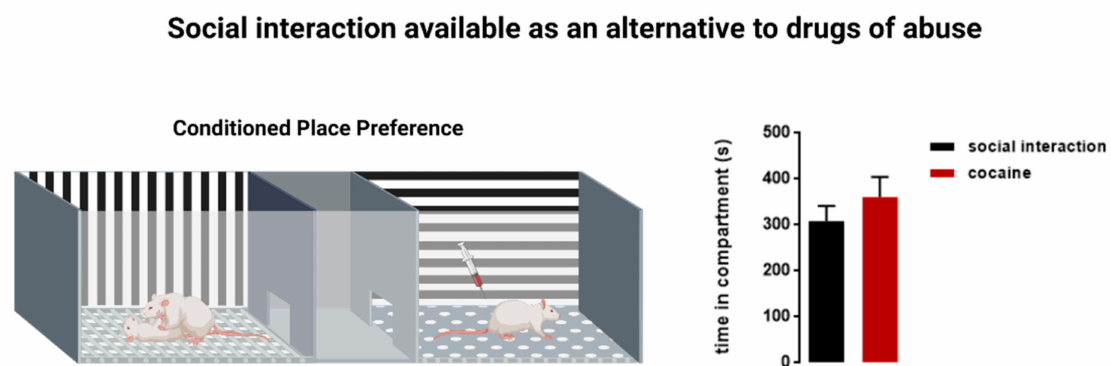
Figure 1. Social interaction as an alternative to drugs of abuse. A conditioned place preference (CPP) apparatus comprises a neutral central compartment connected to two chambers that are different in their context (vertical versus horizontal stripes on the walls) and texture (round versus square holes on the floor). During the conditioning phase, the animal is placed in one chamber of the CPP (in this example, the horizontal compartment) and receives a stimulus such as a cocaine intraperitoneal injection. The animal will then associate the effect of the stimulus with the corresponding context. In a concurrent CPP procedure, another stimulus, such as social interaction with an age and weight-matched conspecific, is made available in the alternative chamber (in this example, the vertical compartment) during the conditioning sessions. Thus, the animals are conditioned with cocaine in one compartment of the CPP and in the opposite compartment, they are conditioned with a social stimulus to incite social play behavior. That way, an animal will associate the context of the vertical compartment with the rewarding effects of social play. On the test day, when the doors to the stimulus-associated compartments are open and the animal is given the choice of where to spend more time, it will spend a similar amount of time in the cocaine-associated, and in the social interaction-associated, compartment. Social interaction reward and cocaine reward have an equal reward value [25,26]. Right panel: time rats subjected to a concurrent CPP protocol spent in each compartment during the test. n = 8, Unpaired T-test, t(14) = 0.9666, p = 0.3501 (n.s)